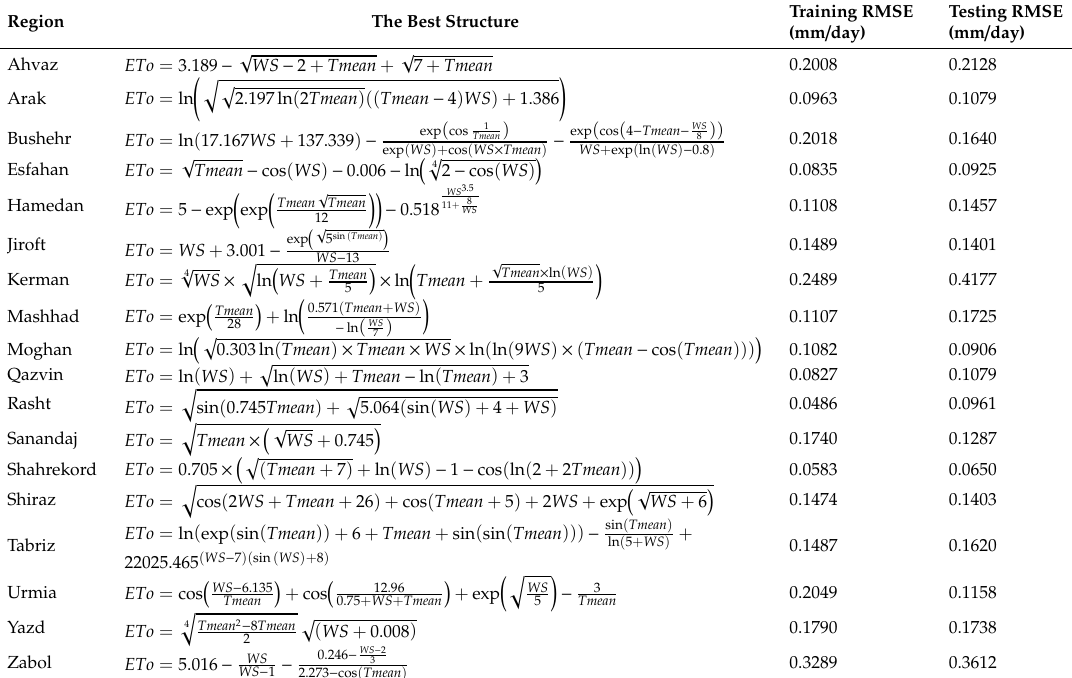
Table 8. Performance of gene expression programming (GEP) for mean temperature (Tmean) and wind speed (WS) as input